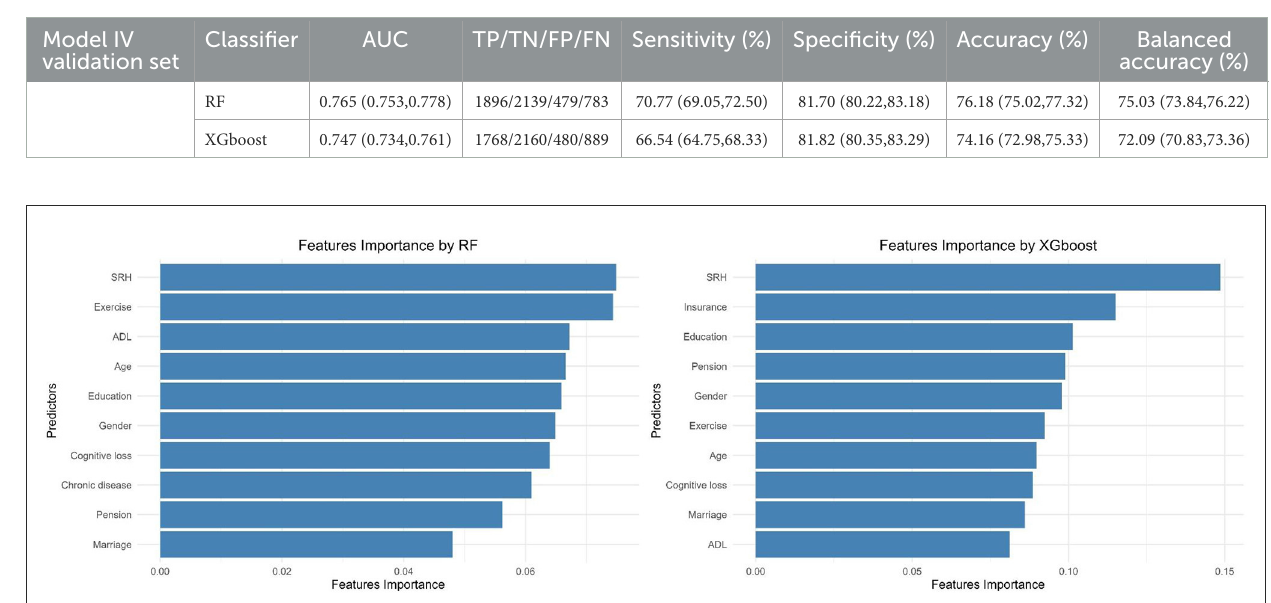
TABLE 3 Validation of RF and XGboost in Model IV.